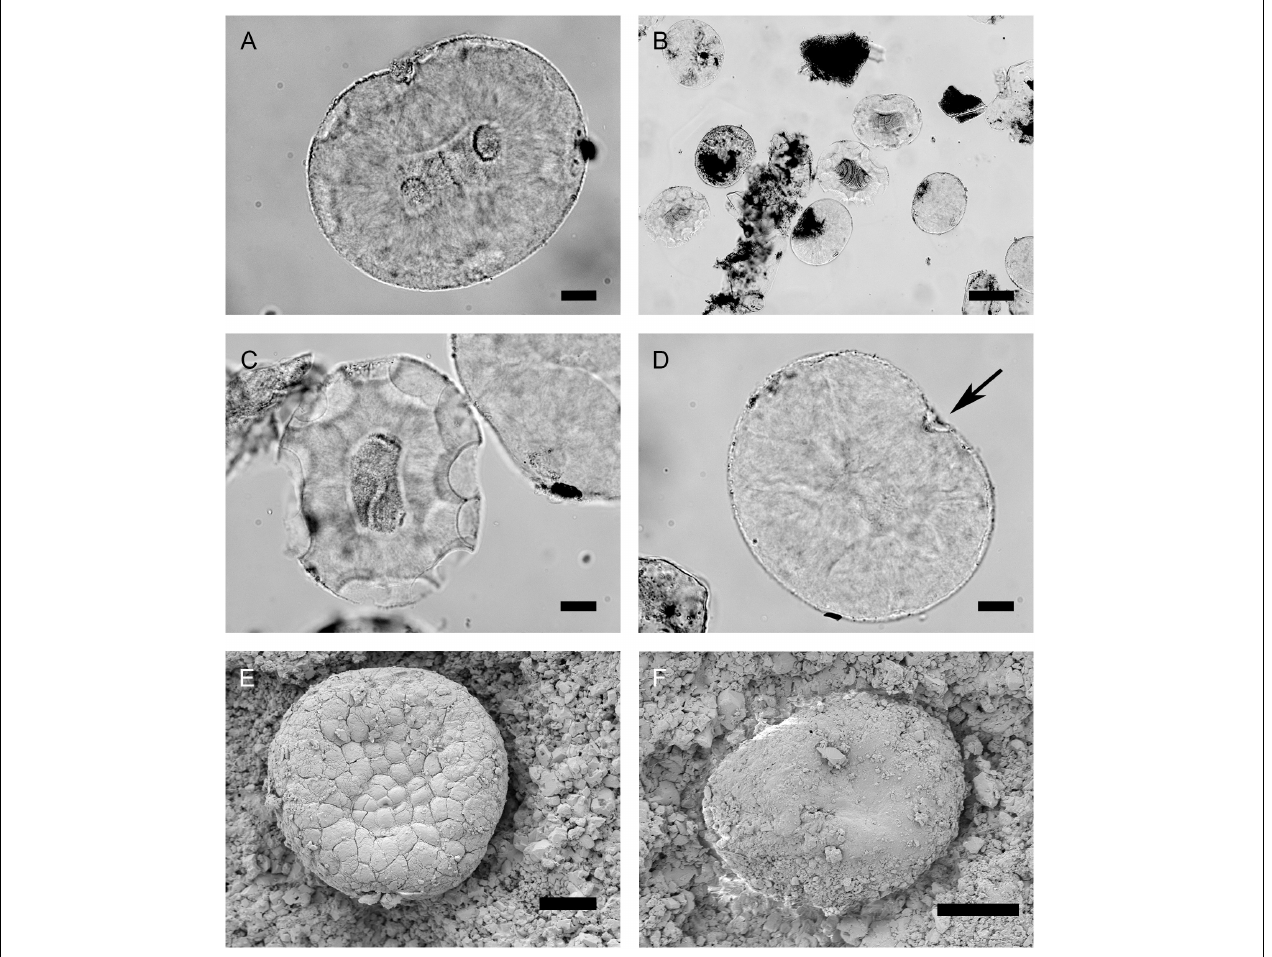
FIGURE 11 | Rhaxes observed with an optical microscope, Rhaxella perforata (now a junior synonym of Rhaxella sorbyana ) (NHMUK PI, slide S1682) from the type locality, Late Jurassic, Oxfordian (Lower Calcareous Grit Formation, Scarborough, North Yorkshire, England). (A) Rhax with typical inside double-dot pattern and fibrous chalcedony recrystallization, seen in transparency. Scale: 20 µ m. (B) Rhaxes with oval to bean shapes. Scale: 100 µ m. (C) Rhax with typical semicircular etching patterns, fibrous chalcedony forming a dark cavity and a radial pattern. Scale: 20 µ m. (D) Bean-shaped rhax with a dent (black arrow), and an etching pattern in the dent. Scale: 20 µ m. (E) Putative subspherical spicule on the surface of Geoditesia jordanensis (specimen S10–18), Callovian, Middle Jurassic. The secondary surface polygonal pattern is typical of fibrous chalcedony recrystallization. Scale: 20 µ m. (F) Putative subspherical spicule on the surface of G. jordanensis (specimen S10–18). Scale: 20 µ